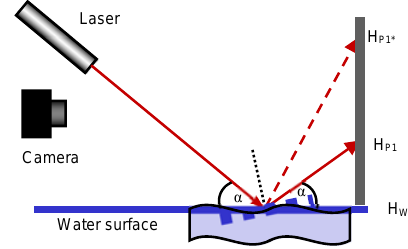
Figure 4: Effect of water movement on height measurement